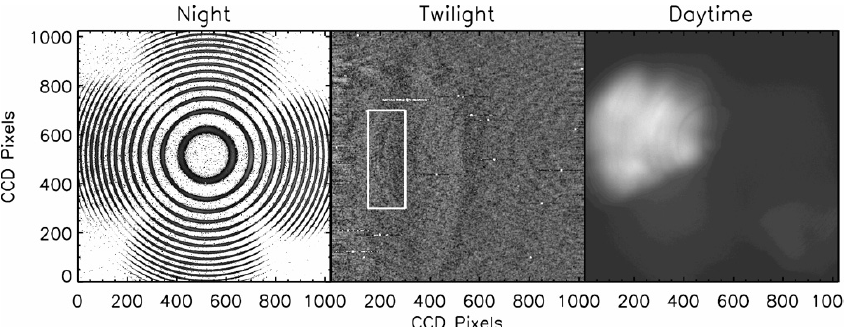
Fig. 1. Raw SOFDI data as imaged onto a CCD for three different observing conditions. left) Typical OI 630-nm nighttime data from all four field-of-views (hence four distinct quadrants) for just the high resolution etalon. Each fringe from each field-of-view yields an independent thermospheric wind measurement corresponding to that field-of-view. middle) Typical twilight data from one field-of-view for all three etalons in place. This image has been median filtered and smoothed to better display the OI fringe within the white bounding box. right) Raw daytime data showing the solar continuum and nearby absorption